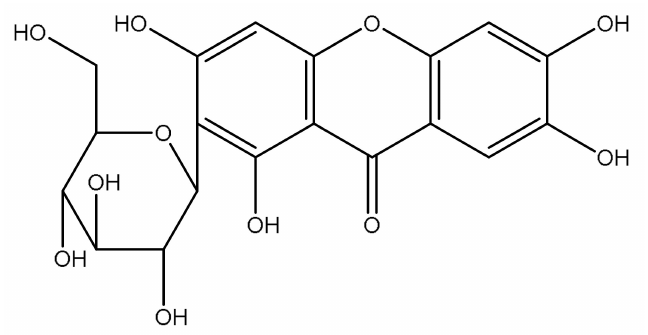
Figure 1. Chemical structure of